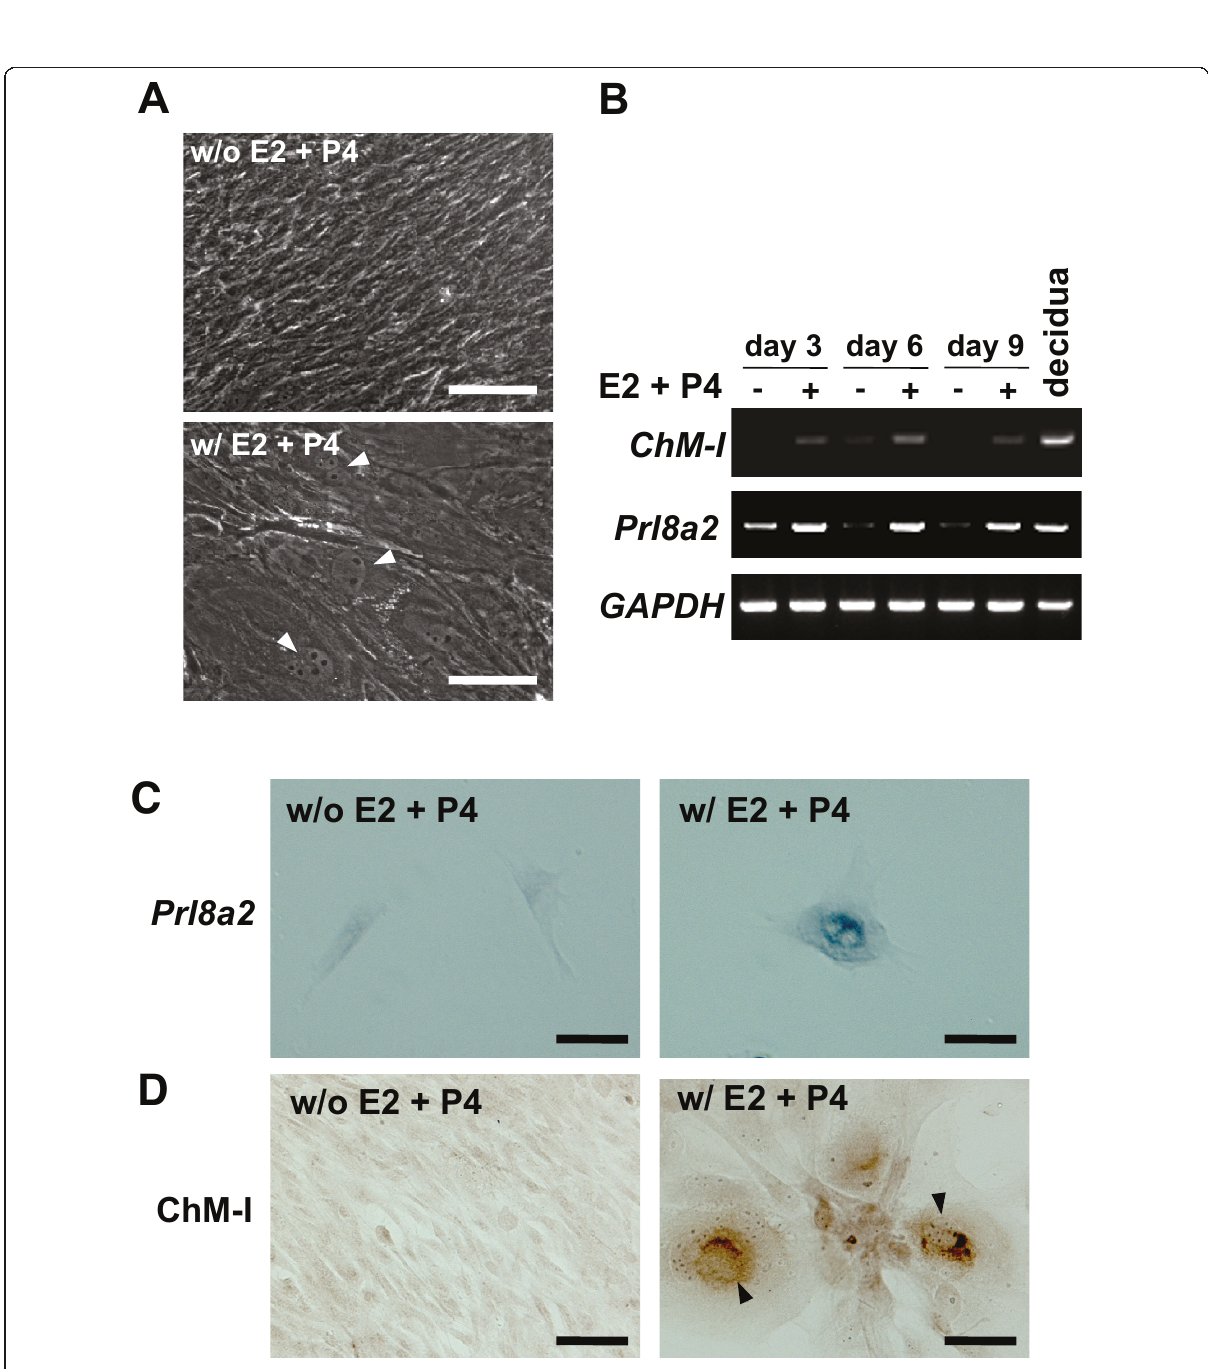
Figure 6 Induction of ChM-I expression during the decidualization of mouse endometrial stromal cells in vitro . Mouse endometrial stromal cells were enzymatically isolated from the uteri of 4 week-old non-pregnant mice and cultured in medium containing 10% charcoal- stripped FBS. The in vitro decidualization of endometrial stromal cells was induced by the addition of E2 (0.1 nM) and P4 (100 nM) to the culture media. (A) Representative microphotographs of the endometrial stromal cells cultured for nine days in the presence (lower panel) or absence (upper panel) of E2 + P4. Arrowheads indicate enlarged or multi-nucleated cells that are characteristic of decidual cells. Bars, 50 μ m. (B) Expression of ChM-I and Prl8a2 in decidualized cultures of endometrial stromal cells. Total RNA was extracted from the cells at the indicated time points and from mouse decidua (7.5 days p.c.). One microgram of each total RNA preparation was reverse-transcribed and analyzed by RT-PCR (35 cycles) for comparison. GAPDH was used as an internal control. (C, D) Expression of Prl8a2 gene in decidualized cells and immunostaining of ChM-I protein. The endometrial stromal cells were cultured for six days with or without E2 + P4, fixed, and subjected to in situ hybridization for Prl8a2 (C) and immunostaining with anti-ChM-I antibody (D). Note that intense signals for ChM-I protein (arrowheads) were observed in enlarged cells that also expressed Prl8a2 . Bars, 30 μ m. All images are representative of three independent